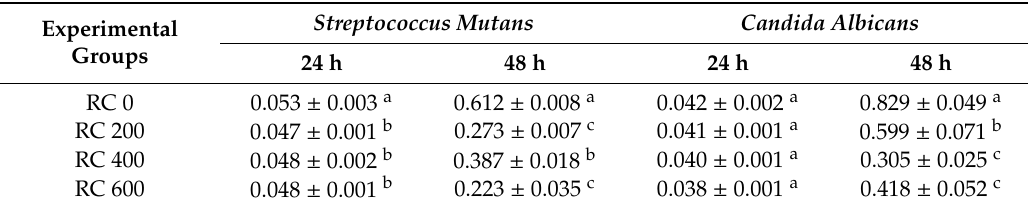
Table 1. Optical density value of the control and experimental groups with Streptococcus mutans and Candida albicans after 24 and 48 h of